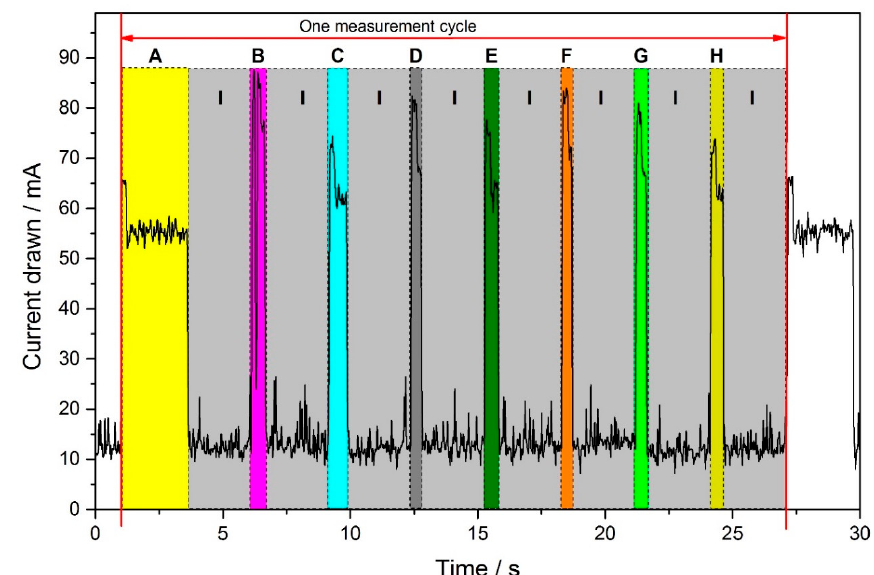
Figure 7. Current usage of a complete measurement cycle, compromising four different temperatures steps for each sensor, in which the resistivity of two sensitive layers from each sensor is estimated. The individual contributions are highlighted.